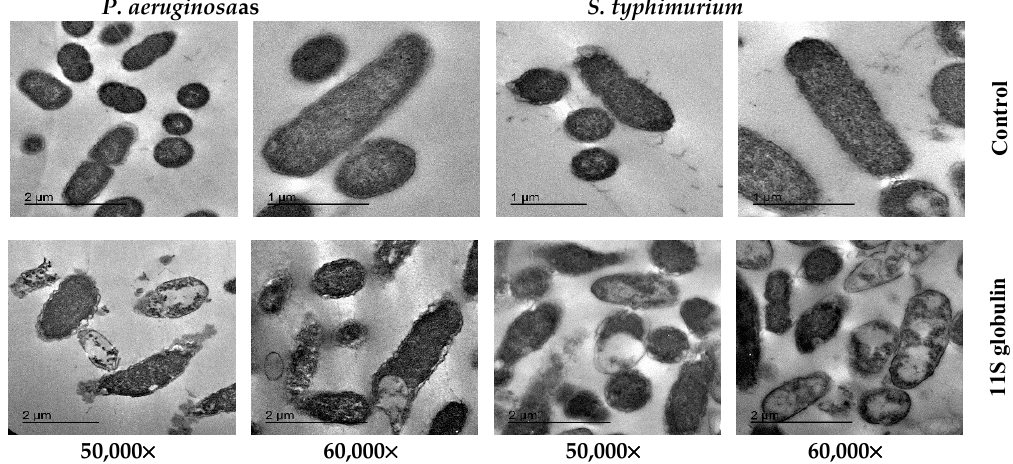
Figure 3. TEM of P. aeruginosa after their incubation at 37 °C for 4 h affected by 25 µg/mL of 11S globulins and S. typhimurium after their incubation at 37 °C for 4 h affected by 200 µg/mL of 11S globulins.